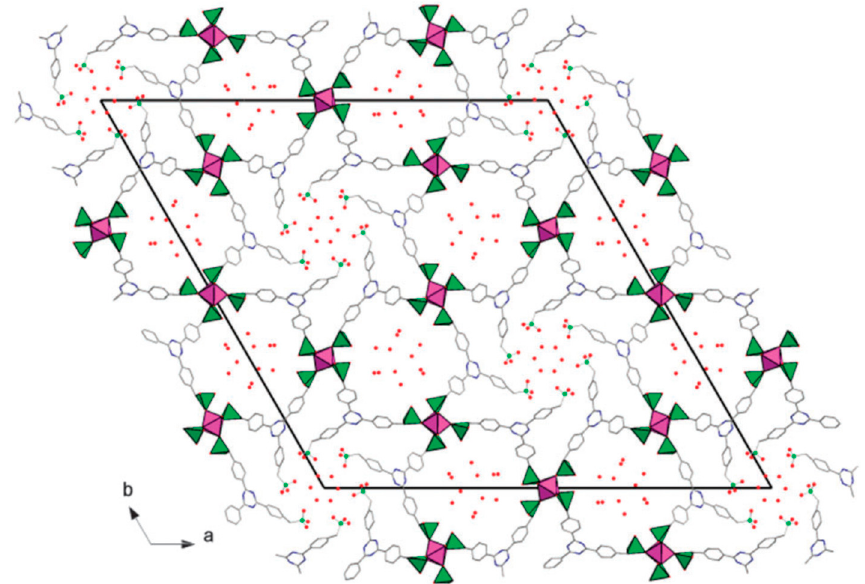
Figure 5. The crystal structure of UPG-1 viewed along the c axis. Color code: zirconium octahedra: purple, coordinating PO 3 C tetrahedra: green. Reprinted with permission from [63]. Copyright (2014), The Royal Society of Chemistry.